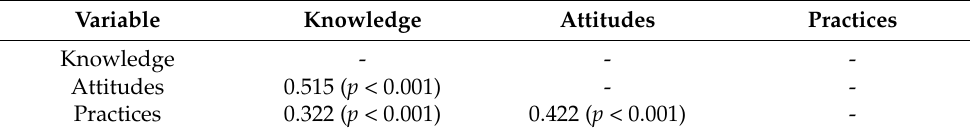
Table 8. Spearman’s correlation coefficient between knowledge, attitudes and